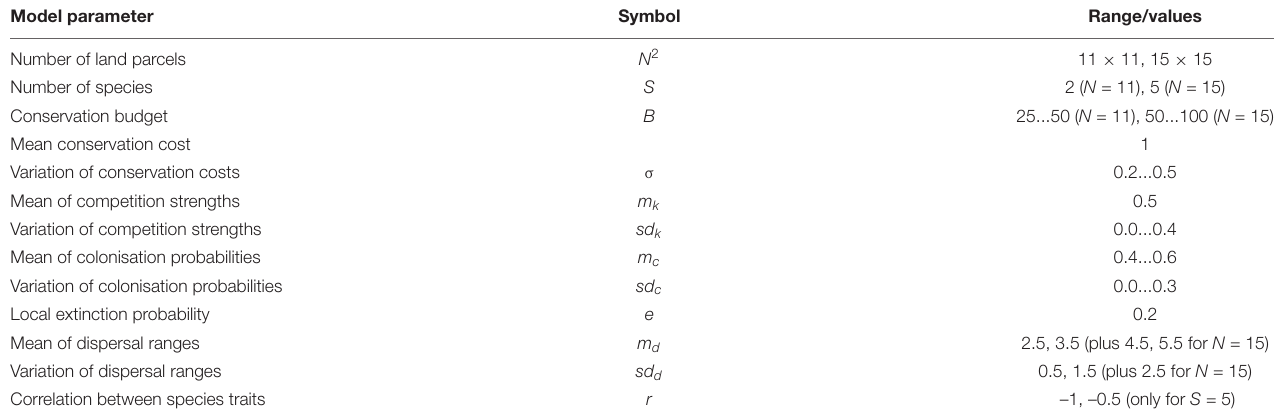
TABLE 1 | Values of the model parameters. Model parameter